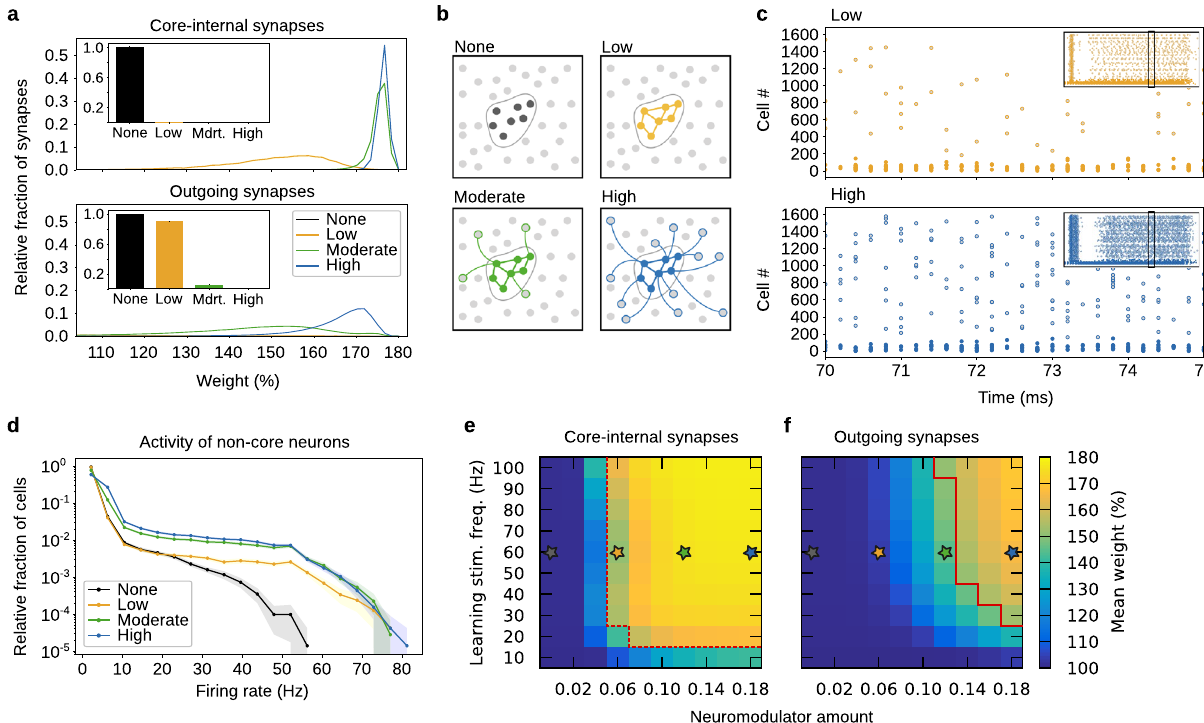
Figure 2. Neuromodulation controls the extent of outgrowth and the activity outside the core assembly. Stars in panels ( e , f ) indicate the four different levels of neuromodulation shown in ( a – d ). ( a ) Distribution of the weights of core-internal synapses and outgoing synapses at recall after 8 h, averaged via bins of ∼ 1.64% . Insets show the fraction of synapses with no substantial late phase ( < 3.26% potentiation, first two bins). ( b ) Sketches of core assembly and outgrowth at four different levels of neuromodulation. Lines represent synapses with consolidated potentiation. ( c ) Spike raster plots showing the spiking of the excitatory neurons during recall stimulation to the first 75 neurons, 8 h after learning. ( d ) Distribution of the firing rates of the excitatory neurons outside the core assembly during recall 8 h after learning. Averaged via bins of 4.16 Hz. ( e , f ) Raster plots showing the mean weight of the core-internal synapses and the outgoing synapses 8 h after learning. The dashed and solid red lines demarcate the regimes where the weights are above 150%. All data except the spike raster plots were averaged over 50 trials. Error bands show the 95% confidence